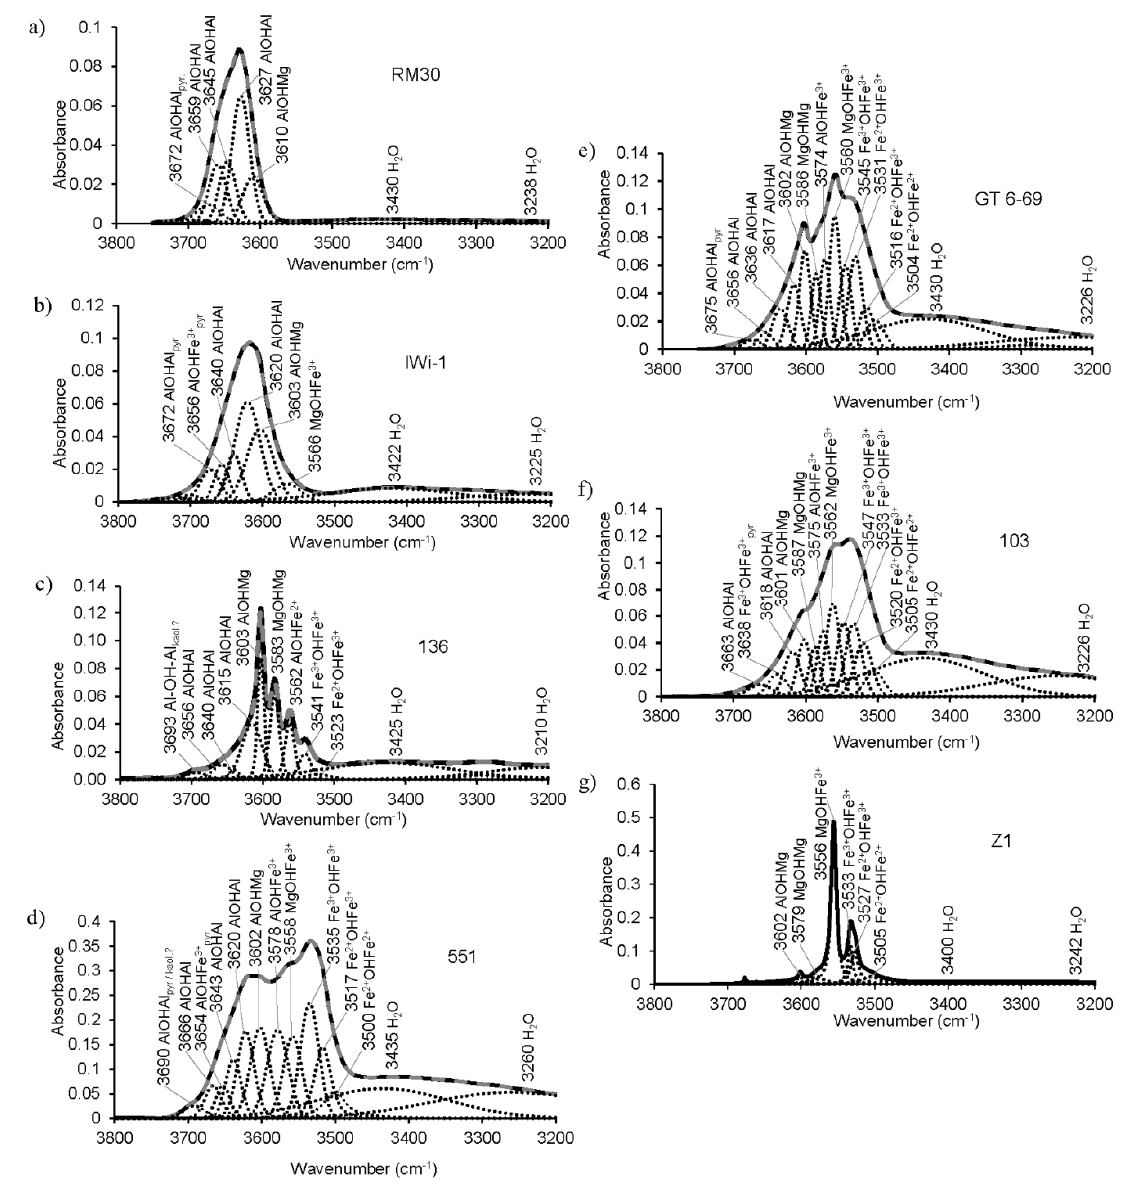
Figure 8. Decomposition and curve-fitting of the FTIR spectra of selected samples in the OH-stretching region: ( a )—RM30; ( b )—IWi-1; ( c )—136; ( d )—551; ( e )—GT6-69; ( f )—103; ( g )—Z1.